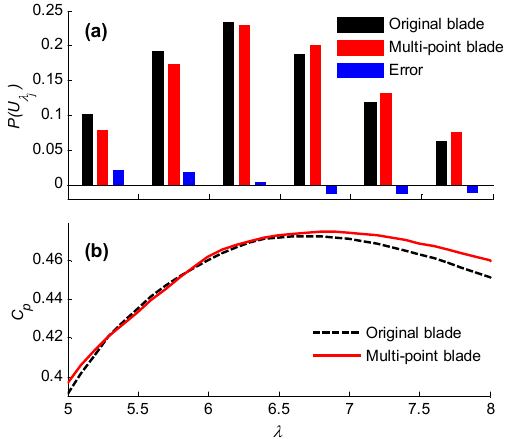
Figure 10. The proportion of the inflow wind energy: ( a ) the power coefficient; and ( b ) for the multi ‐ point and the original blades.